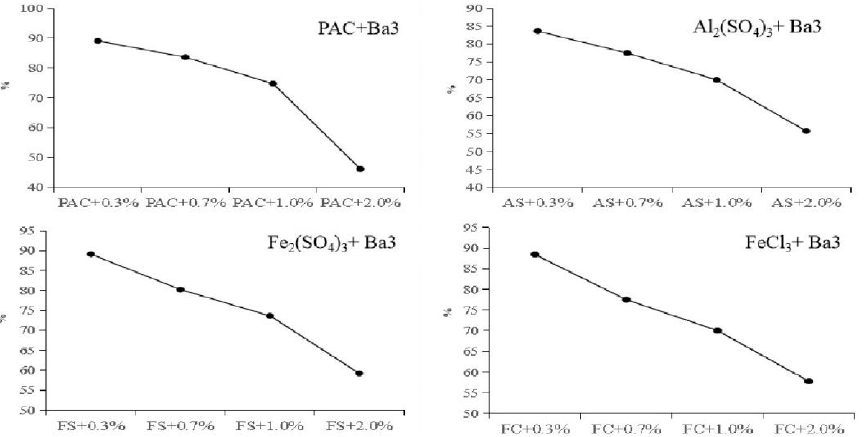
Figure 8. Removal effects on turbidity by the combination of coagulants and fermentation